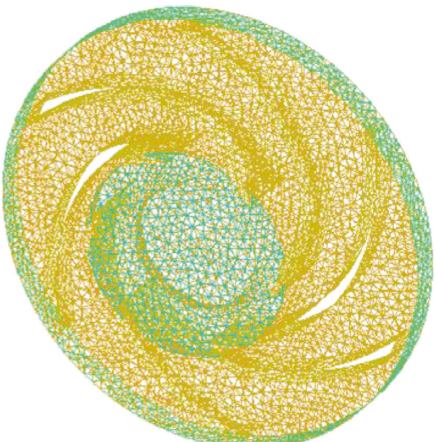
Figure 5: Hydraulic grid of the impeller.